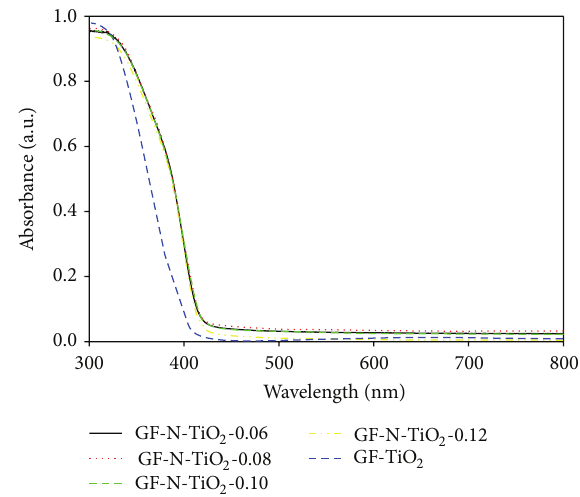
Figure 5: UV-visible spectra of GF-N-TiO 2 -0.06, GF-N-TiO 2 -0.08, GF-N-TiO 2 -0.10, GF-N-TiO 2 -0.12, and GF-TiO 2